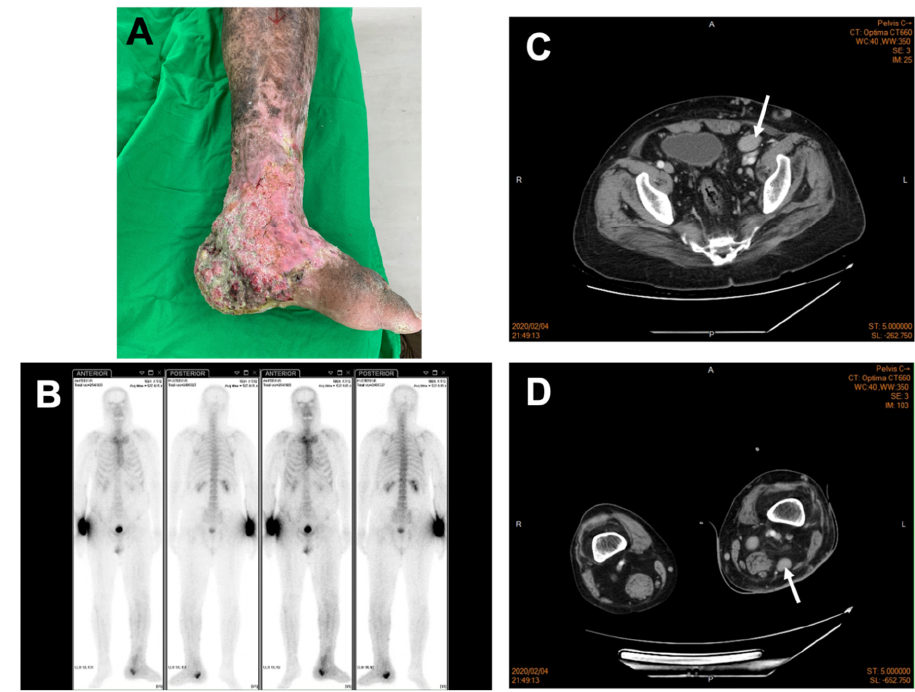
Figure 1. Preoperative image evaluation of the left lower leg and foot SCC. ( A ) SCC presented as pigmented skin and chronic ulcers below the left knee, especially at ankle and heel; ( B ) Tc-99m MDP whole-body bone scan revealed increased radioactivity in the left calcaneus, extraosseously over the left lower leg and foot (due to soft tissue swelling), calvarium, thoracolumbar spine (due to certain degenerative change), and focal radiotracer accumulation in the right wrist, which may indicate injection sites; and contrast-enhanced computed tomography showed enlarged and enhanced lymph nodes along ( C ) the left external iliac vessels (greatest diameter: 3.16 cm, white arrow) and ( D ) the left popliteal fossa (greatest diameter: 2.13 cm, white arrow).